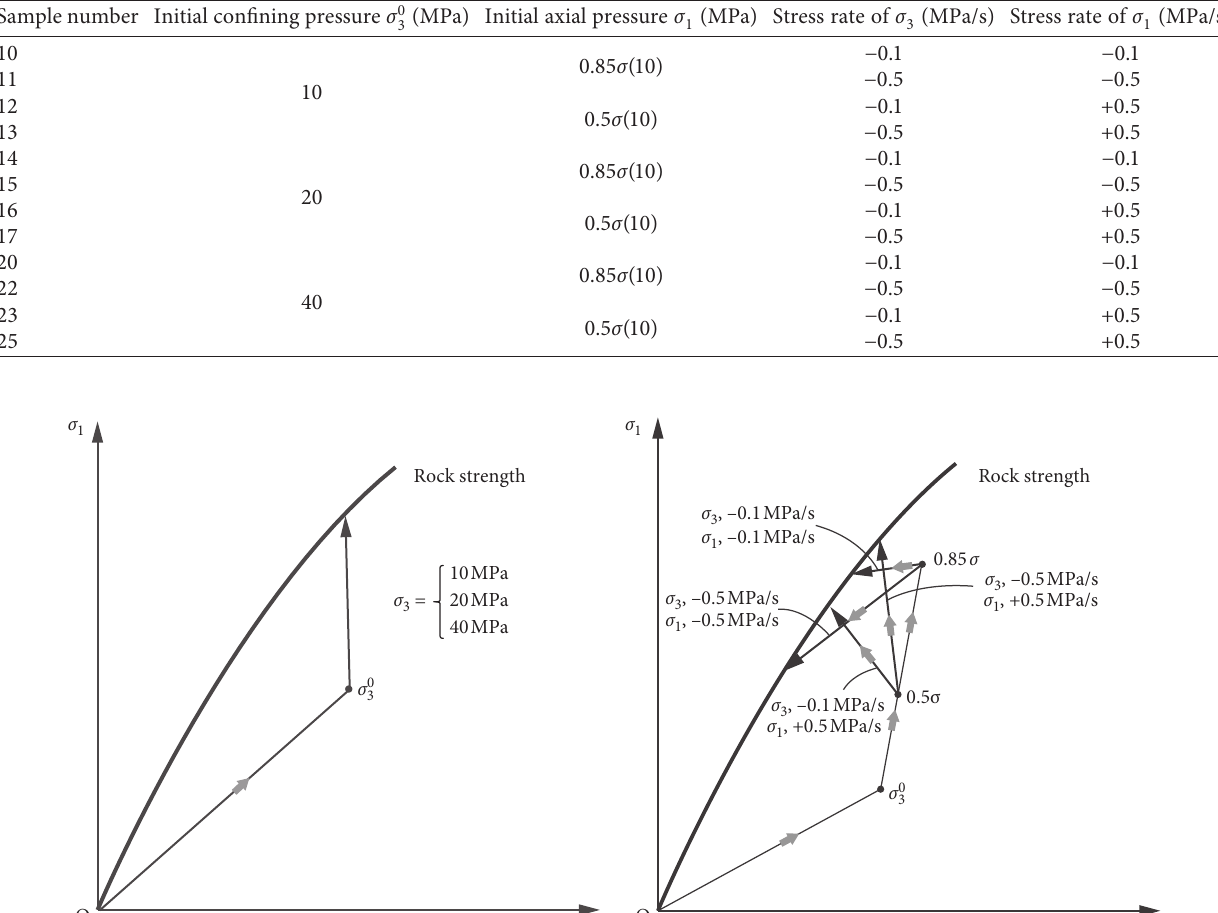
Table 2: Settings for confining pressure and axial stress in complex loading-unloading stress tests (negative values indicate unloading; positive values indicate